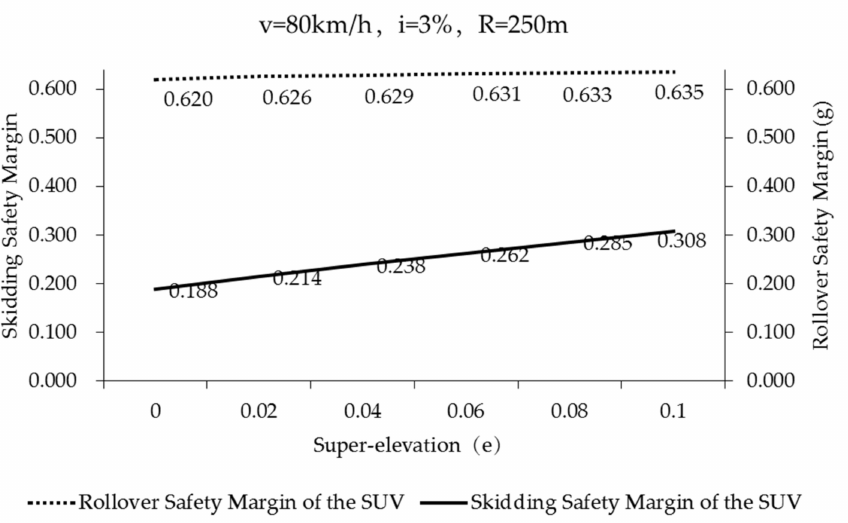
Figure 10. Skidding and rollover safety margin of the SUV on poor friction pavement ( f Tmax = 0.50) (Case 1–6, in Table